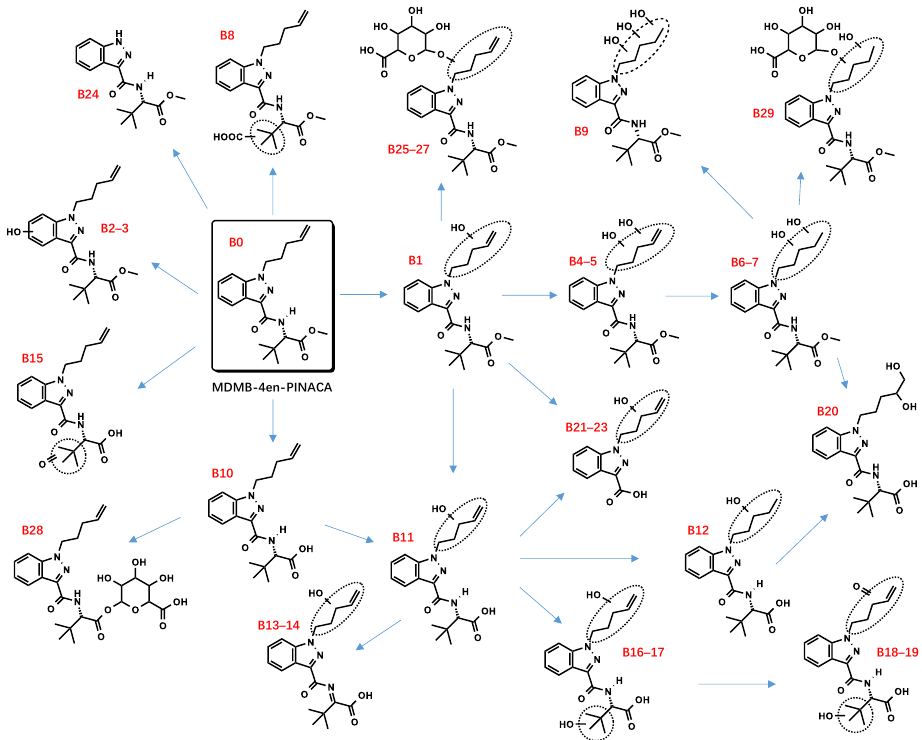
Figure 4. Proposed metabolic pathway of MDMB-4en-PINACA.